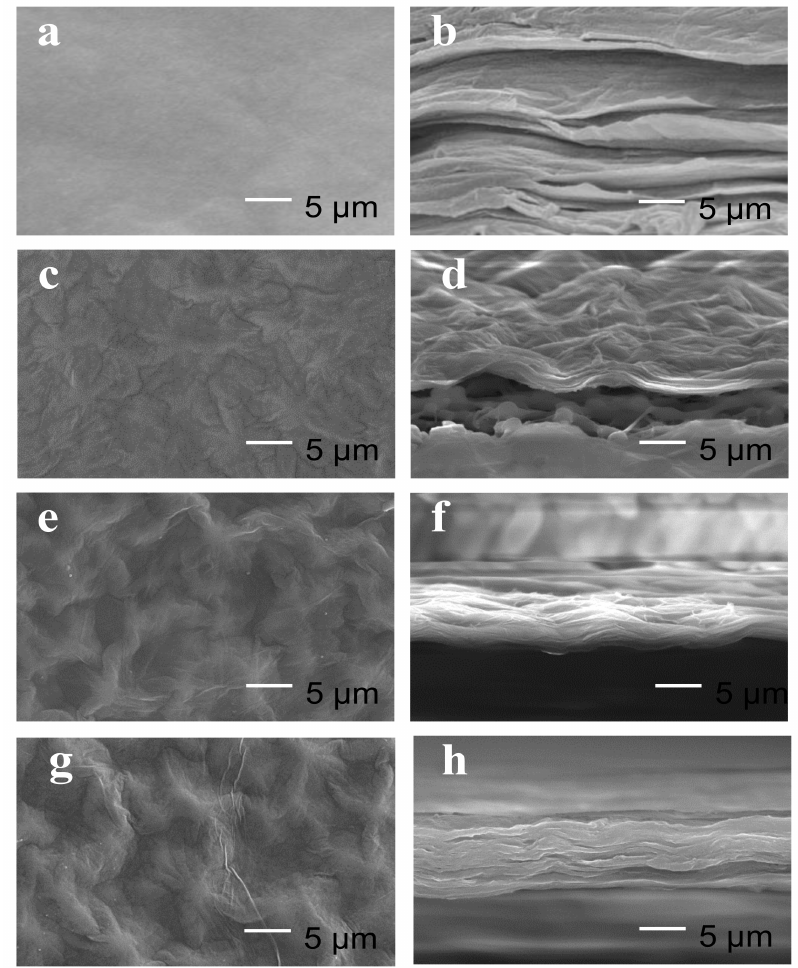
Figure 1. The Scanning electron microscopy (SEM) images of surface graphene oxide membrane (GOM) ( a ), graphene oxide (GO)-L-alanine (Ala) ( c ), GO-serine (Ser) ( e ), GO- L-phenylalanine (PHE) ( g ) and cross-section of GOM ( b ), GO-Ala ( d ), GO-Ser ( f ), GO-PHE ( h